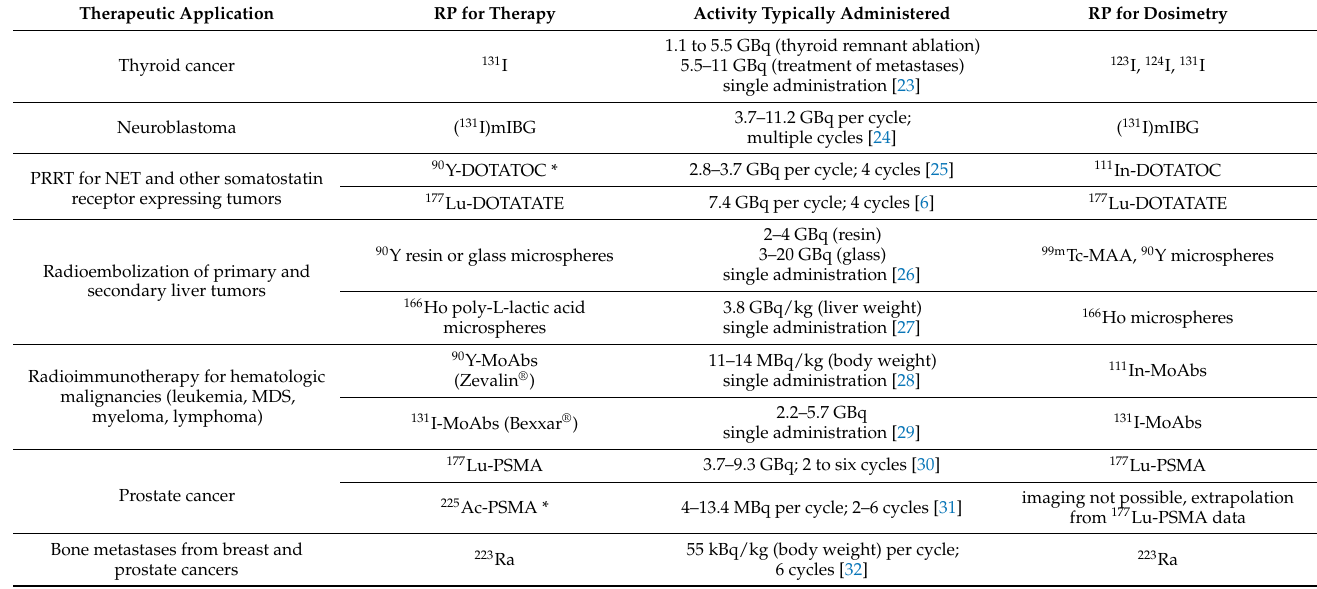
Table 1. Summary of the main radiopharmaceuticals (RP) used in TRT, their therapeutic application and the corresponding administered activity in the treatment. Radiopharmaceuticals used for dosimetry are also reported. * Relating to a research